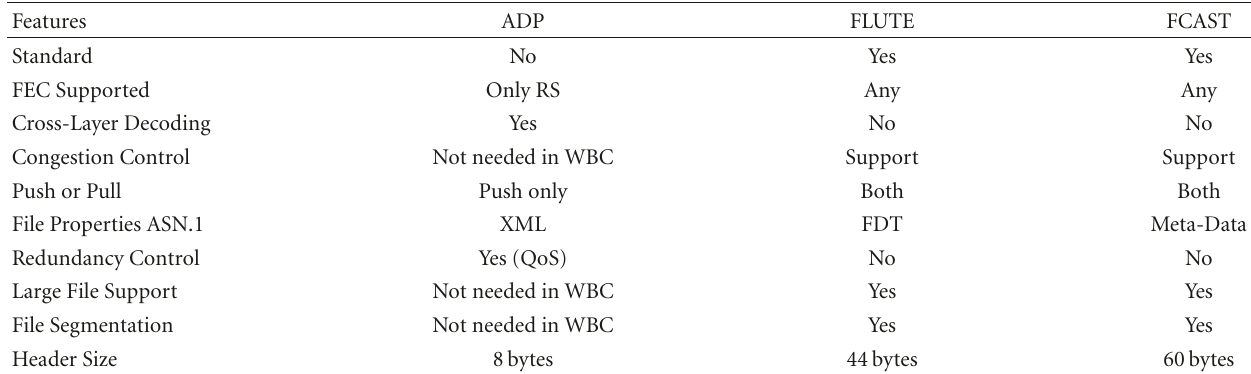
Table 3: ADP, FLUTE, and FCAST